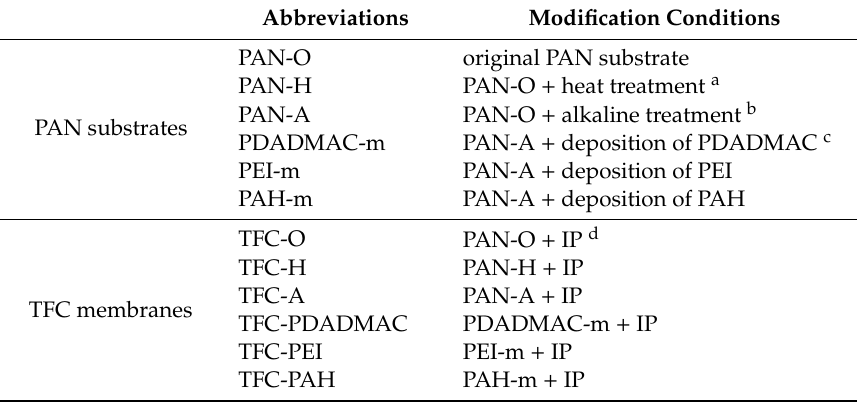
Table 1. Modification conditions for the PAN substrates and the TFC membranes fabricated via IP.